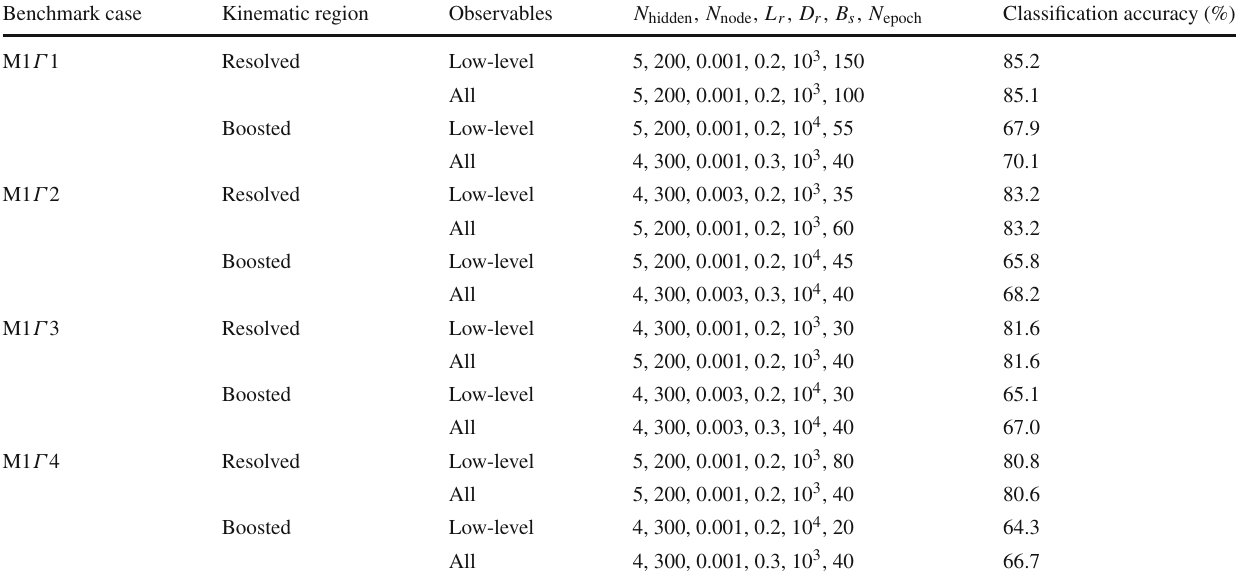
Table 3 The selected networks for M ρ = 1 TeV. N epoch is the epoch number when we cut the training Benchmark case